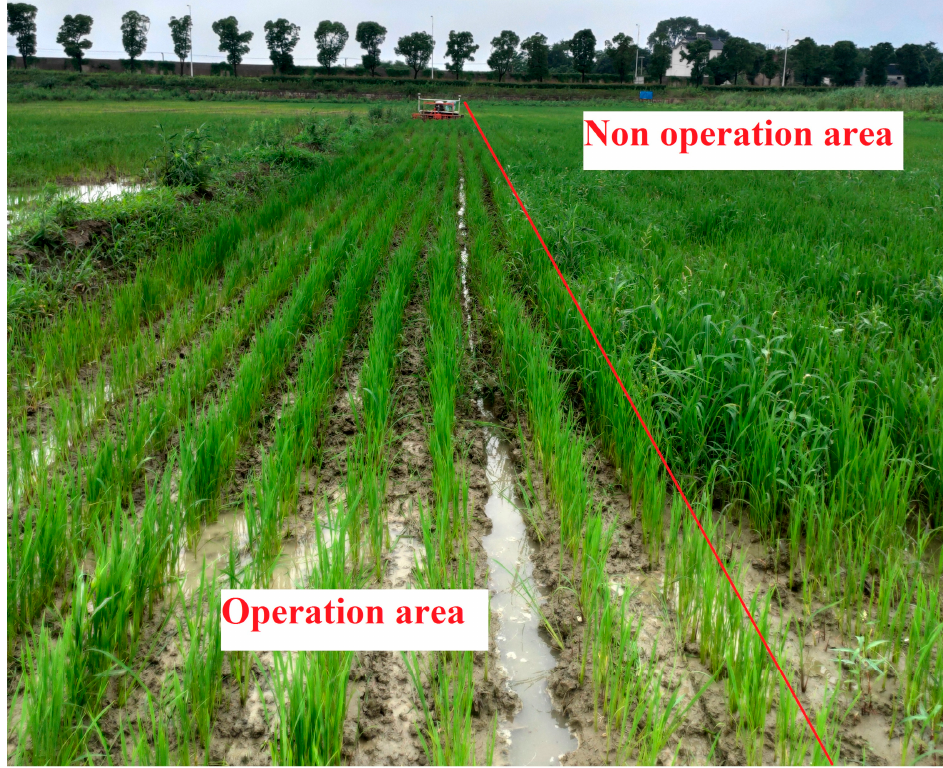
Figure 9. Results of weeding and fertilizing operations using an RFW machine.